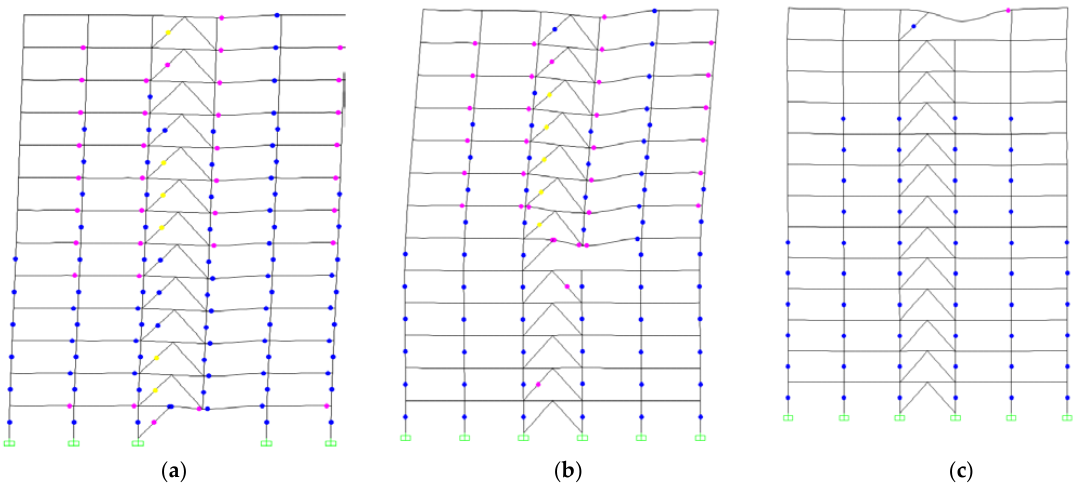
Figure 10. Hinge formation in the inverted V-braced frame exposed to column removal in ( a ) story one, ( b ) story six, and ( c ) story thirteen.